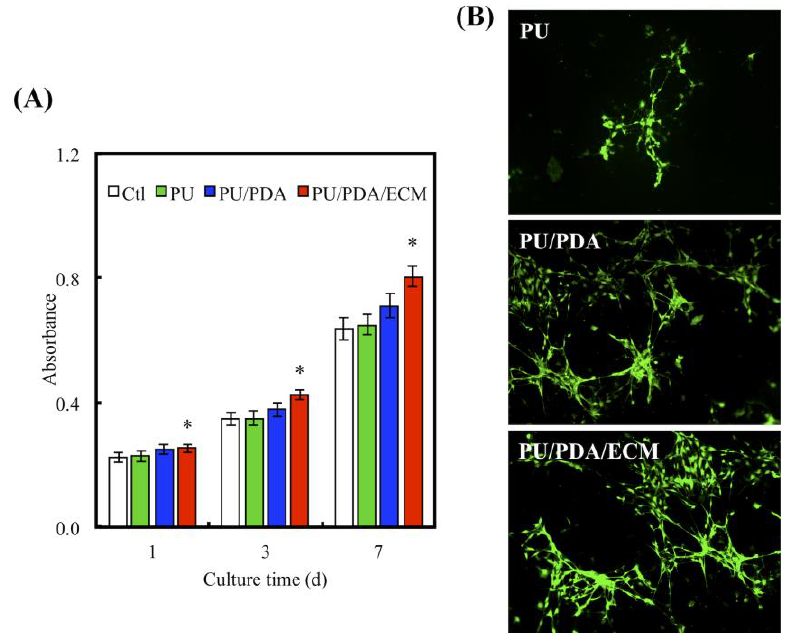
Figure 8. ( A ) Proliferation of HSCs (human Schwann cells) cultured on PU, PU / PDA, and PU / PDA / ECM conduits for 1, 3, and 7 days. * indicates a significant difference ( p < 0.05) compared to Ctl. ( B ) F-actin staining of HSCs seeding on PU, PU / PDA, and PU / PDA / ECM conduits for 3